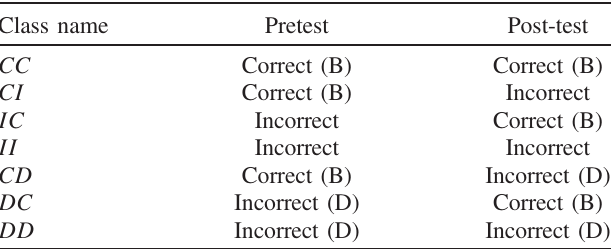
TABLE III. Classifications of response pairs.